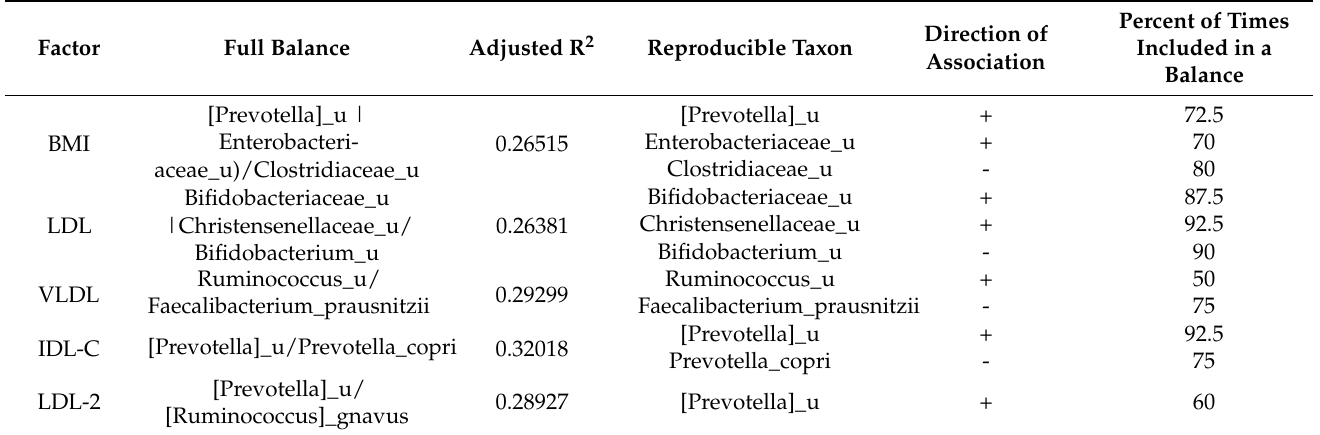
Table 4. Relationship between the gut microbiota composition, subfractional spectrum of serum apo-B containing lipopro- teins and BMI, selbal test